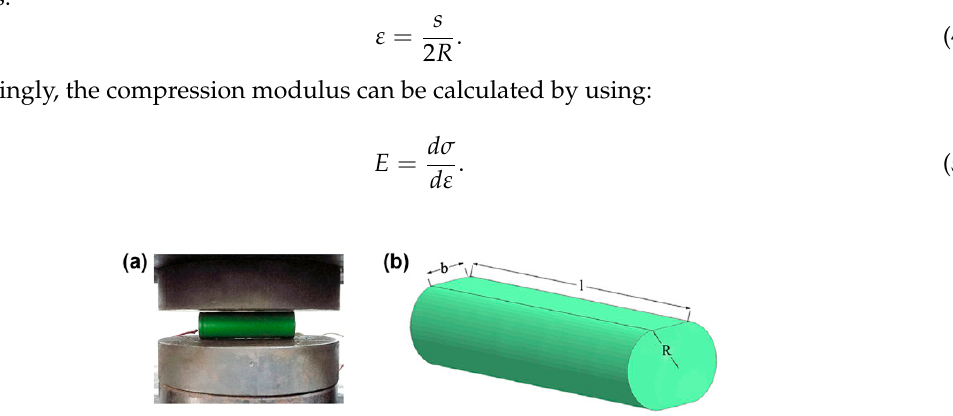
Figure 2. ( a ) Photograph of a pressure head of the universal testing machine and ( b ) schematic of a cylindrical cell during compressing.